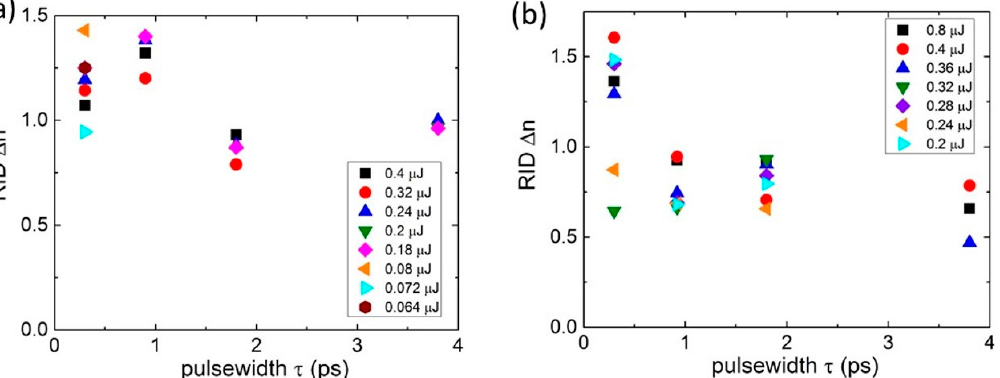
Figure 4. Refractive index difference (RID) Δ𝑛 = 𝑅𝑒𝑡 / T versus pulsewidth τ at different 515 nm ( a ) and 1030 nm ( b ) laser pulse energies (symbols of different shapes and colors). Maximal relative error bars ≤ 10%.